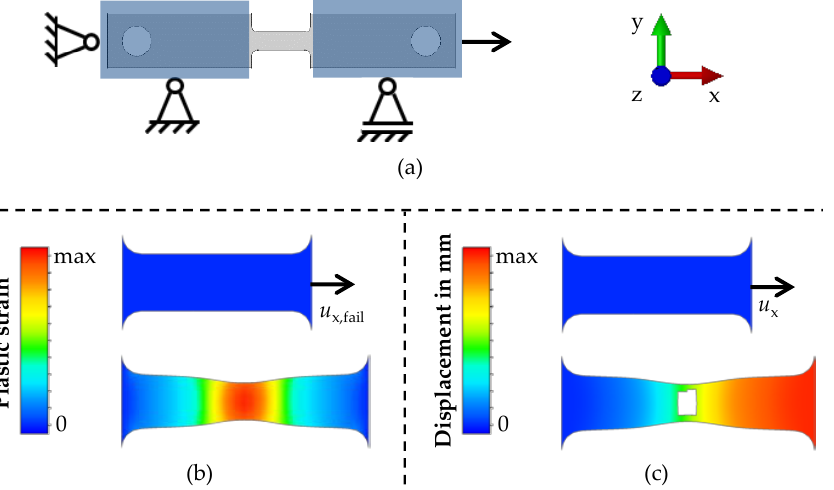
Figure 2. Geometry of the simulation model ( a ); and the boundary conditions for the comparison of the hardening model ( b ) and for the failure model ( c ).